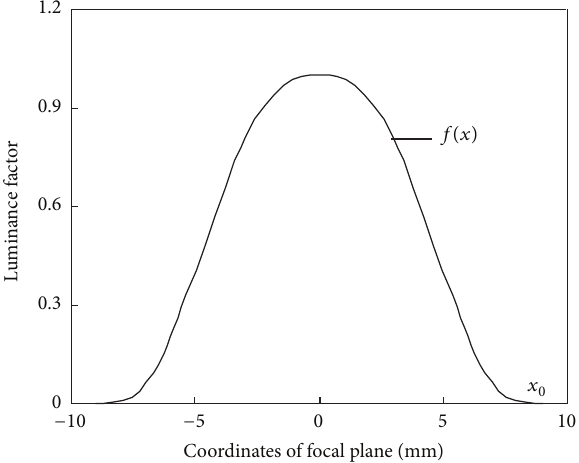
Figure 9: The parabolic trough solar concentrator of measuring energy density distribution.